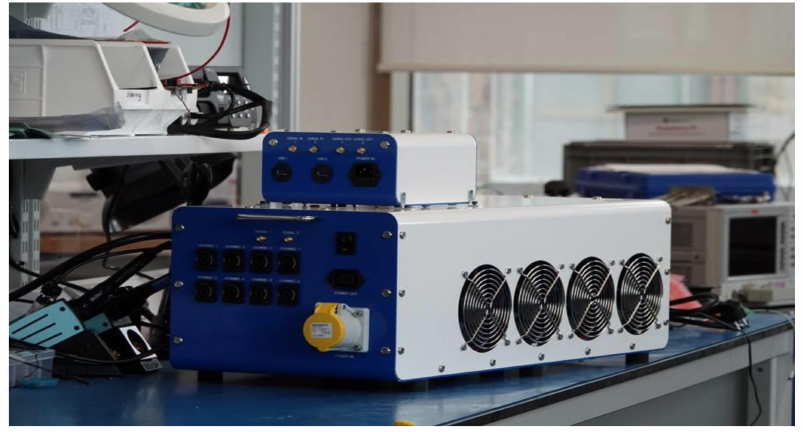
Figure 8. Multi-channel power/signal generator for power ultrasonic